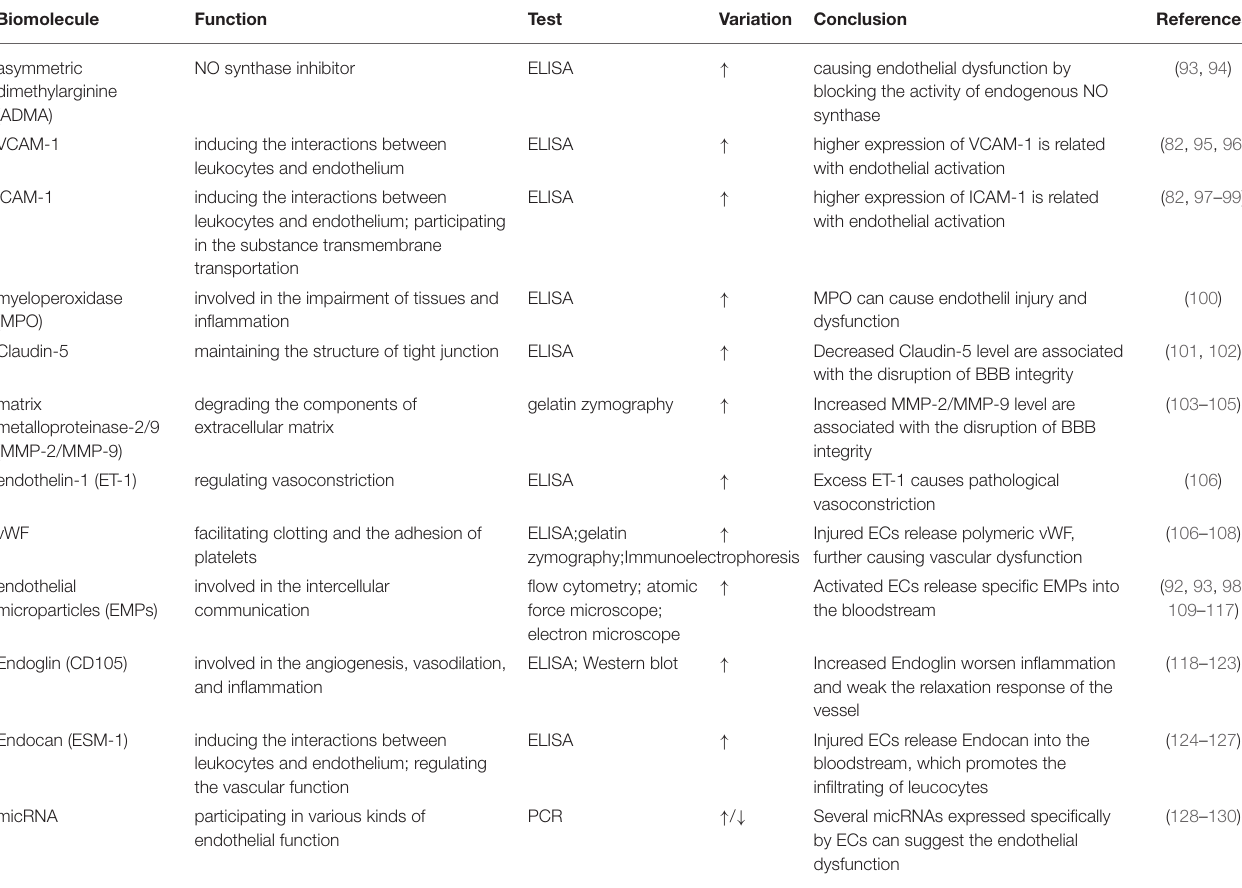
TABLE 3 | Potential biomarkers of endothelial